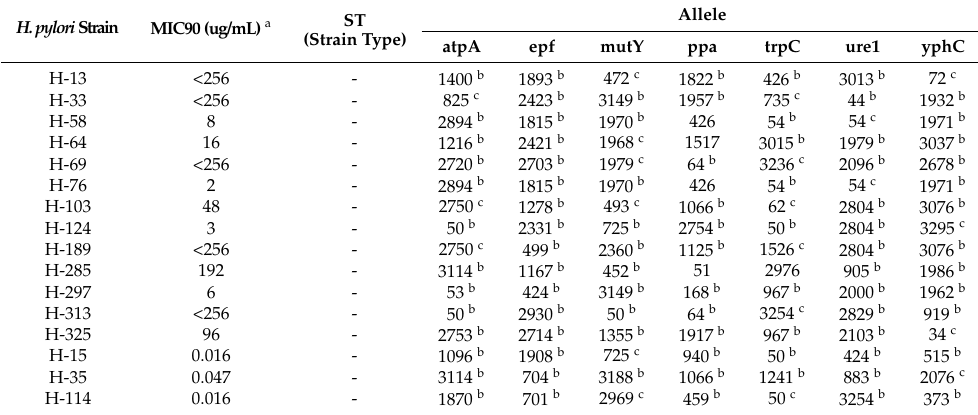
Table 3. MLST results for clarithromycin-resistant and -sensitive strains. H.pylori